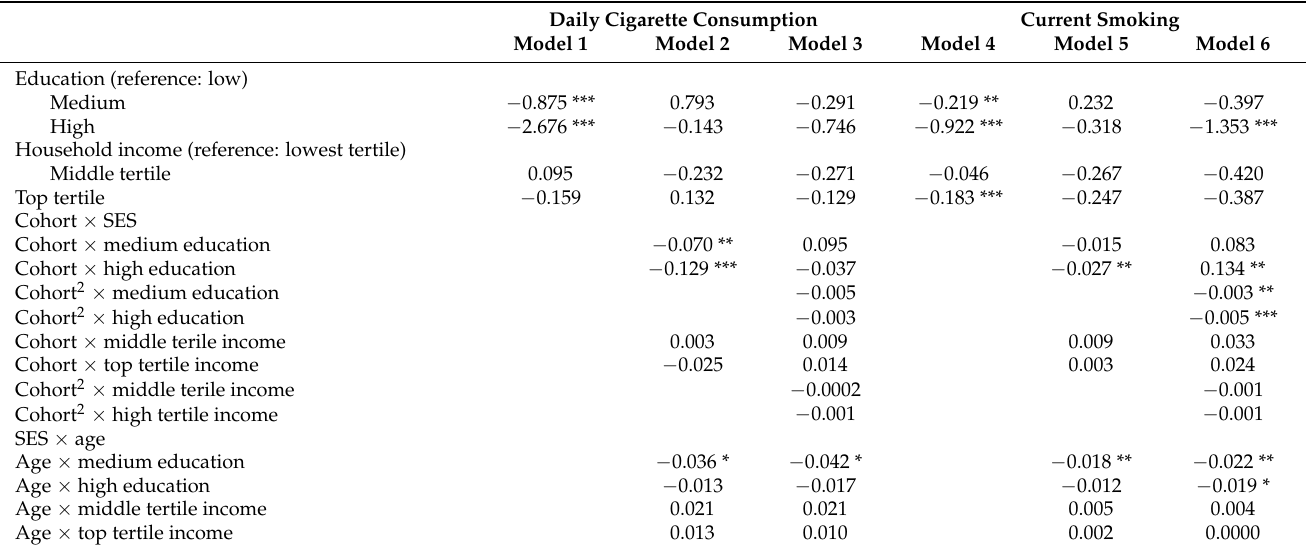
Table 2. Inter- and intra-cohort changes of socioeconomic gaps in smoking